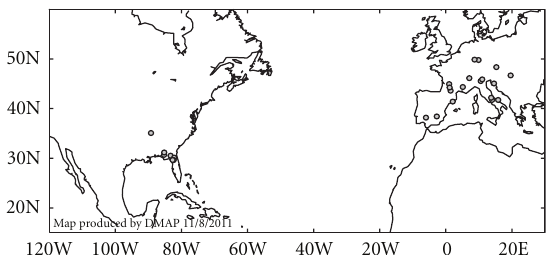
Figure 9: Distribution of Myrmicinosporidium sp. Eight ant host species are known from USA, and 19 from